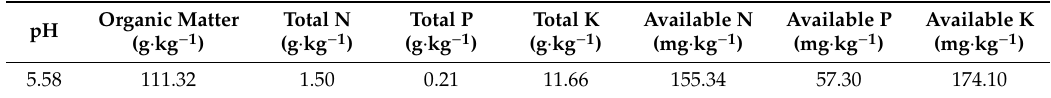
Table 1. The basic soil chemical